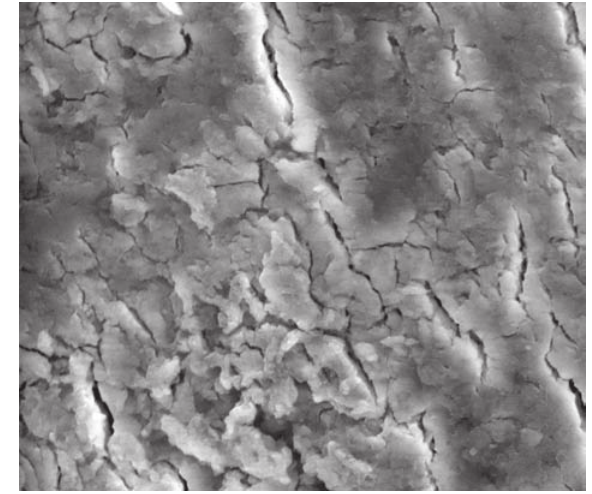
Figure 1- Scanning Electron Microscopy (SEM) micrograph of a root canal irrigated with Aquatine EC and a rinse of EDTA. All dentinal tubules are visible and the smear layer was completely removed